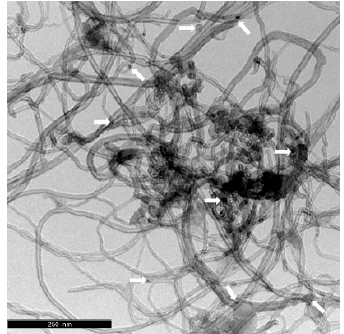
Figure 1. TEM image from the Fe/CNT catalyst.